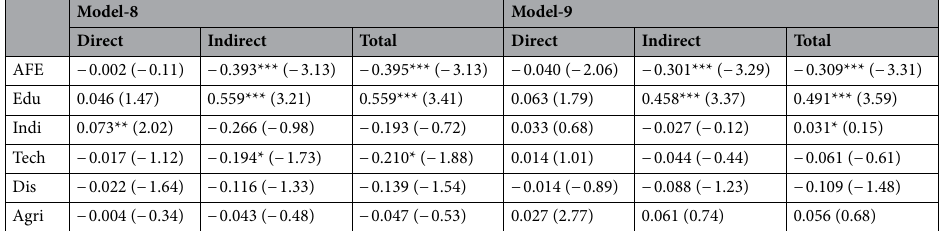
Table 7. Direct, indirect, and total effects under Model-8 and Model-9. *, **, *** indicate significance at the 10%, 5% and 1% level. For the estimated coefficients, the standard errors are in